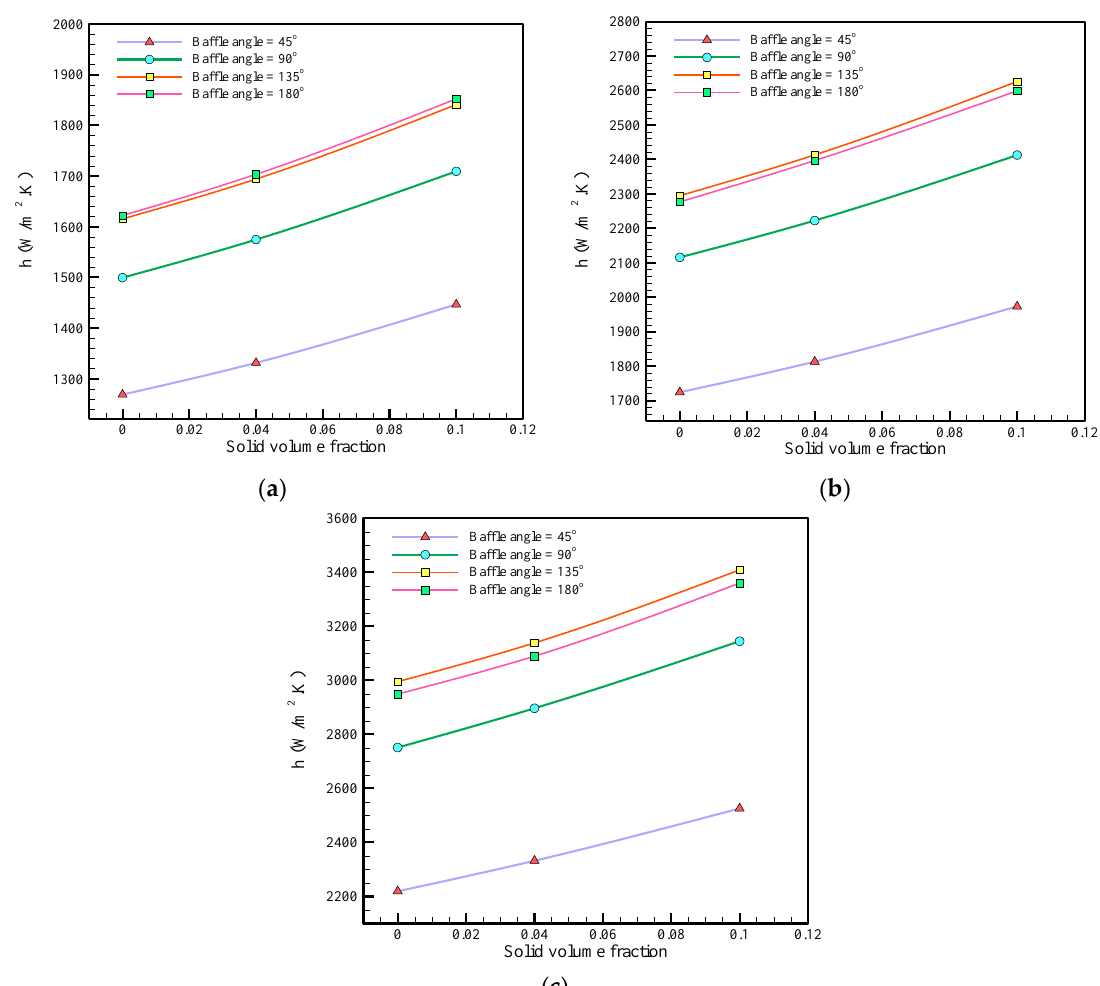
Figure 8. Heat transfer coefficient against solid volume fraction at various baffle angles with Reynolds numbers of ( a ) 10,000, ( b ) 15,000, and ( c ) 20,000.